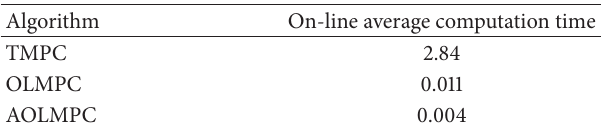
Figure 3: The ellipsoids defined by 𝑄 −1 𝑖 for every other ten ellipsoids discrete points for Example 12. Table 1: The corresponding average computation